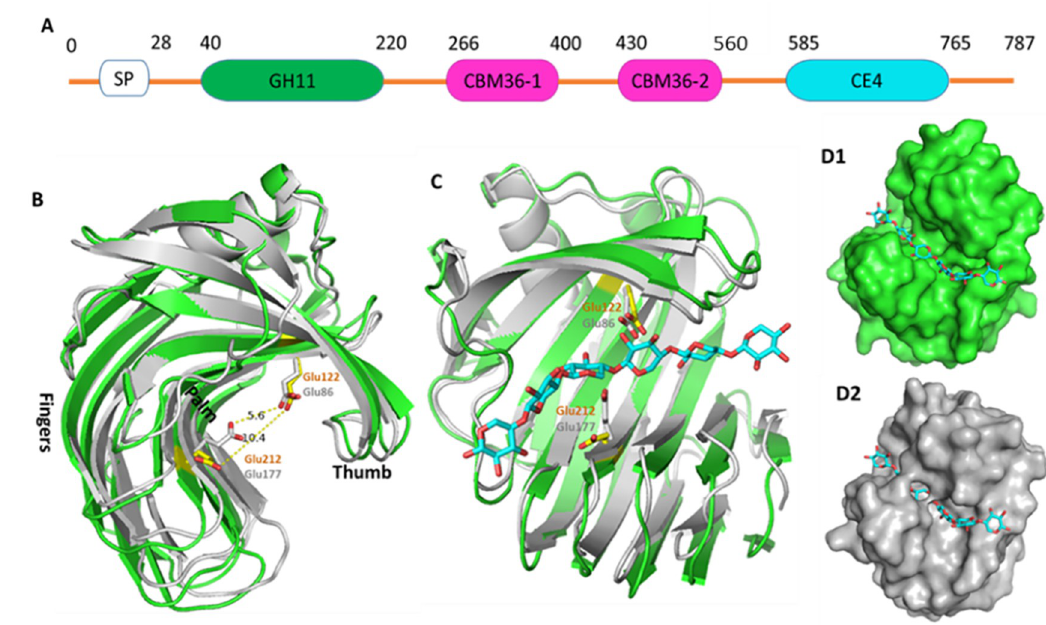
Fig 1. Domain structure of Xyl and crystal structure of the Xyl-GH11. A) An N-terminal secretion signal peptide (SP) is followed by a GH11 catalytic domain (green), two carbohydrate binding modules CBM36-1 and CBM36-2 (magenta), and an esterase CE4 catalytic domain (cyan). B) Crystal structures of Xyl-GH11 (green) superimposed on the crystal structure of TrXyn11 (gray) showing the “fingers” and “palm” (outer and inner β -sheets), and the “thumb” loop. The catalytic residues are shown as sticks. Glu177 of TrXyn11 adopts an “up” conformation (gray) whereas the corresponding residue Glu212 in Xyl-GH11 is in the “down” conformation (yellow). C) Xylohexose modelled into the active site of Xyl-GH11 and TrXyn11. Surface view shows the modelled substrate is enclosed by the enzyme in TrXyn11 with the up conformation (D2 ) but open in Xyl-GH11 ( D1 ).